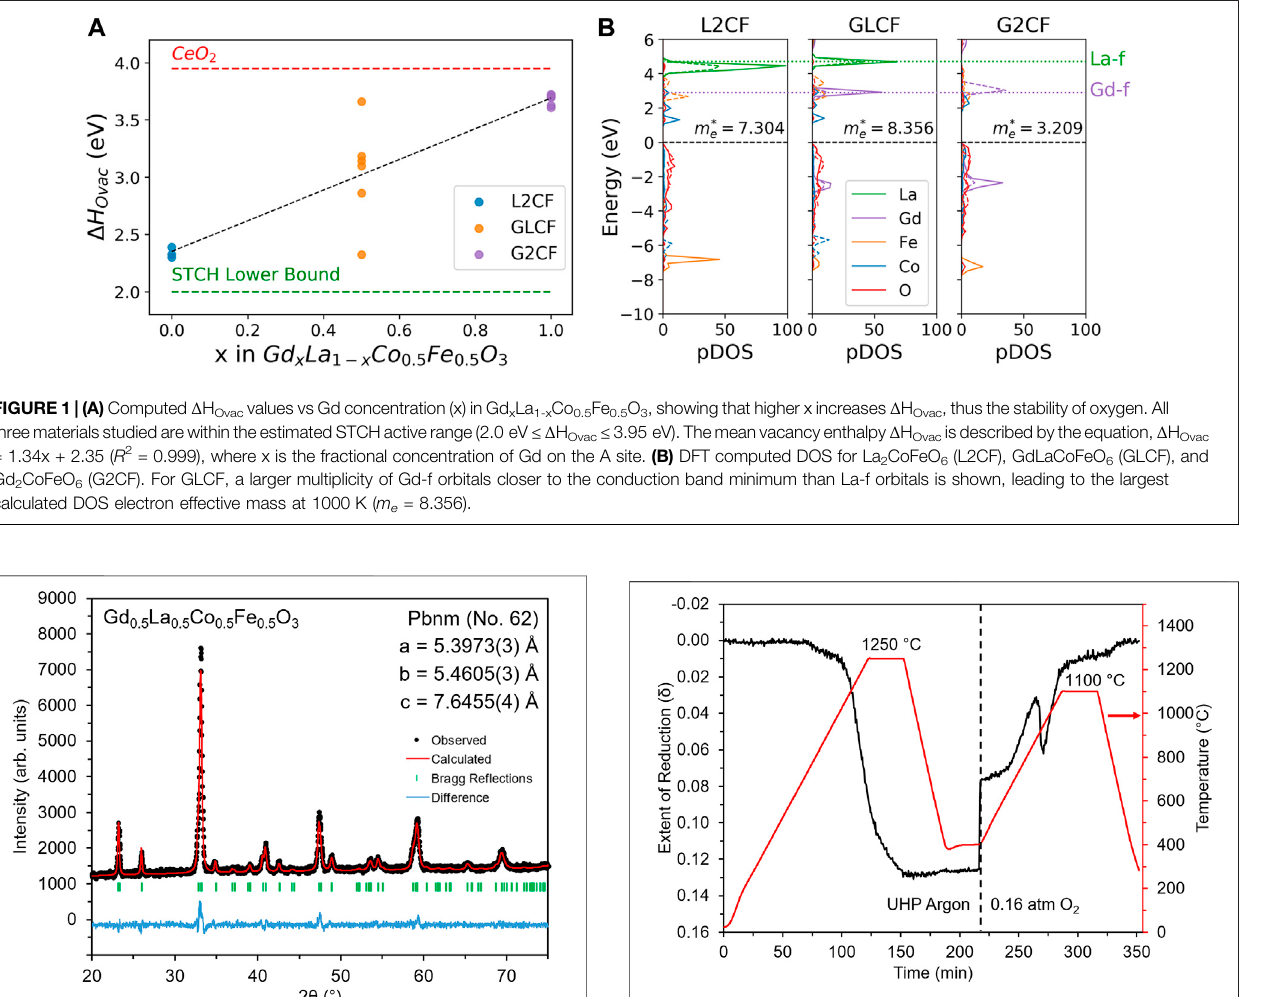
FIGURE 2 | Room temperature XRD pattern with LeBail pro fi le fi tting for Gd